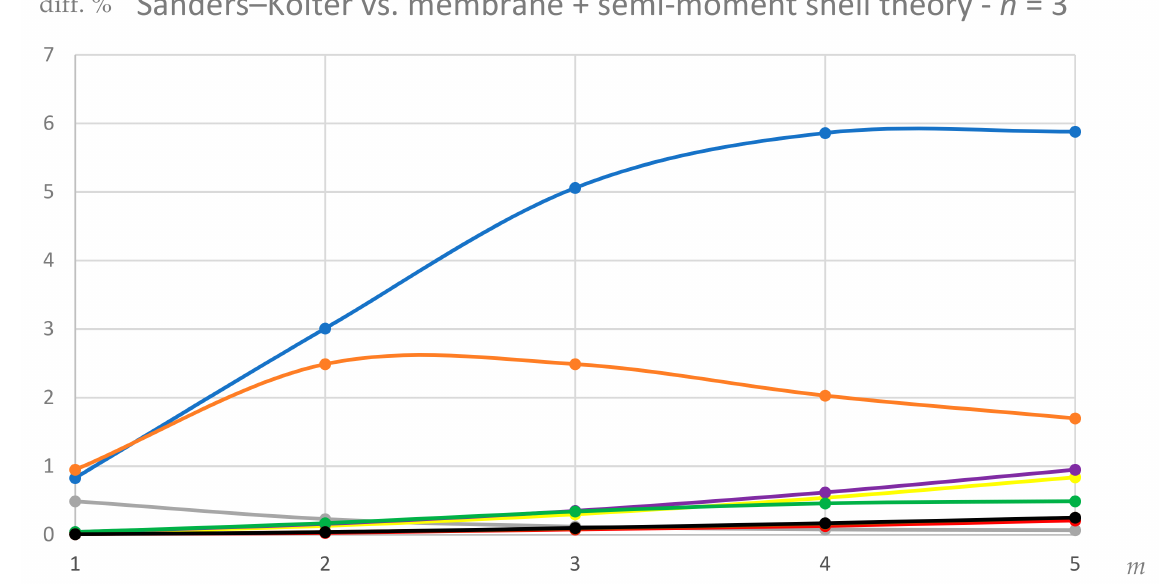
Figure 13. Simply supported DWCNT of Table 1 with different values of aspect ratio L / R 2 and thickness ratio R 2 / h . Shell-like modes ( n = 3). Comparisons between extended Sanders–Koiter and membrane + semi-moment shell theory, where L / R 2 = 10, R 2 / h = 25;